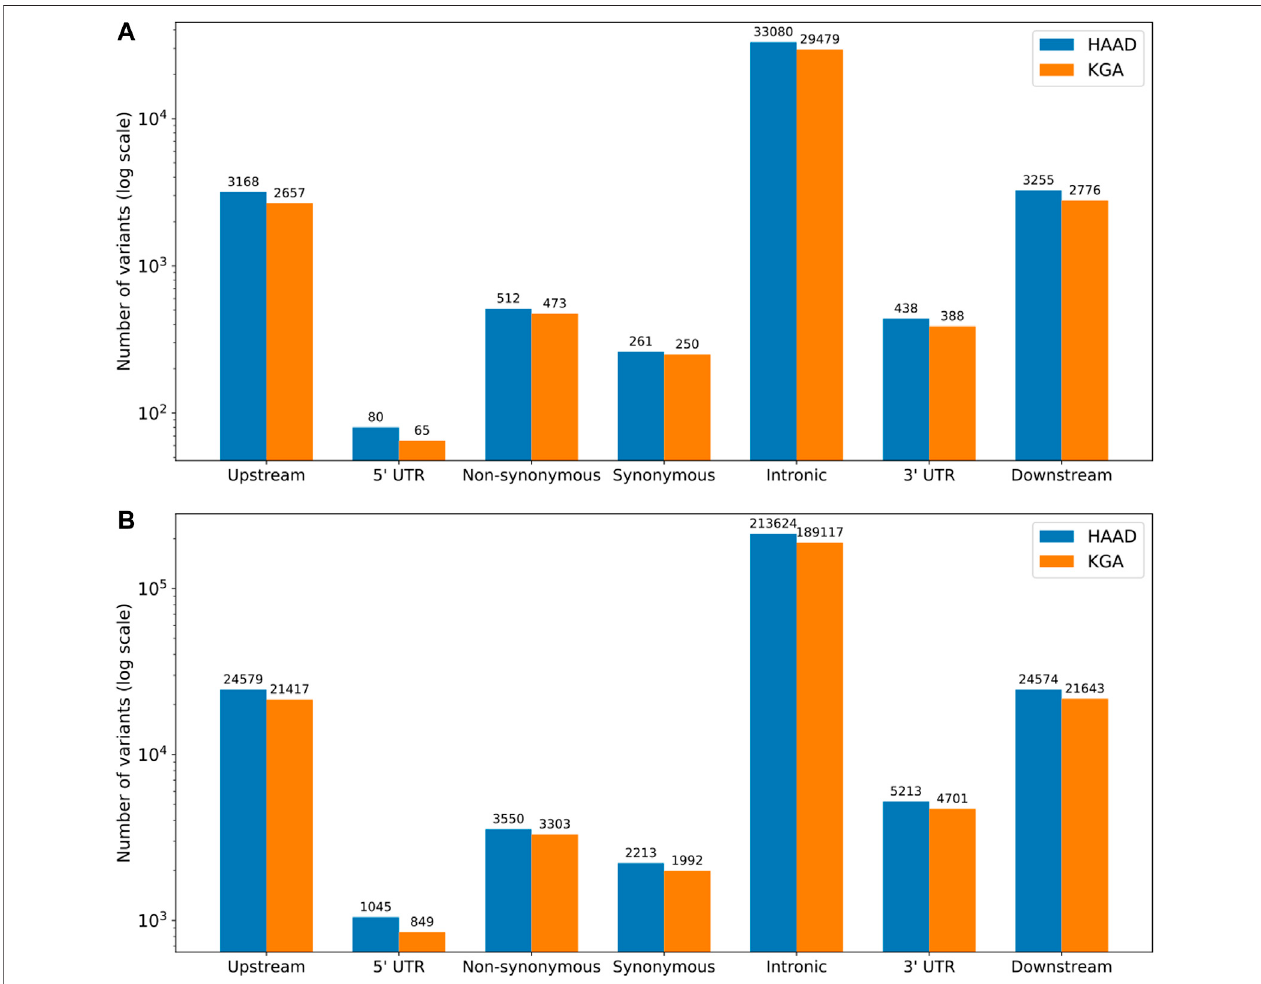
FIGURE3| Distributionofvarianttypes(asde fi nedbySNPeffannotation)acrosscore (A) andextended (B) ADMEgeneregions.HAAD( N (cid:1) 458)representsthose samples in the jointly called set from the H3A Consortium data, Simons Foundation, SAHGP and Tiemessen Labs, and KGA ( n (cid:1) 506) represents the African KGP populations from the jointly called set. Upstream and downstream regions are represented by 10 kb fl anks from gene start and end respectively.